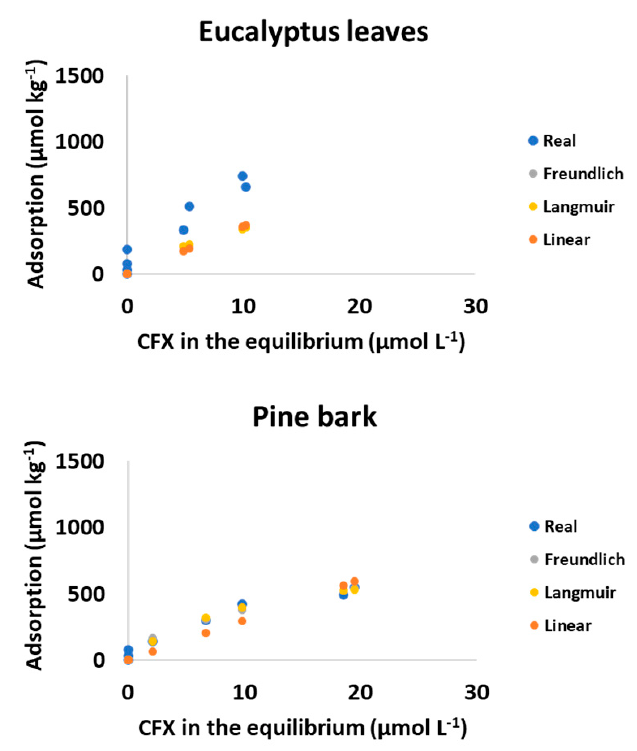
Figure 2. Adsorption curves for CFX also including data of fitting to the adsorption models